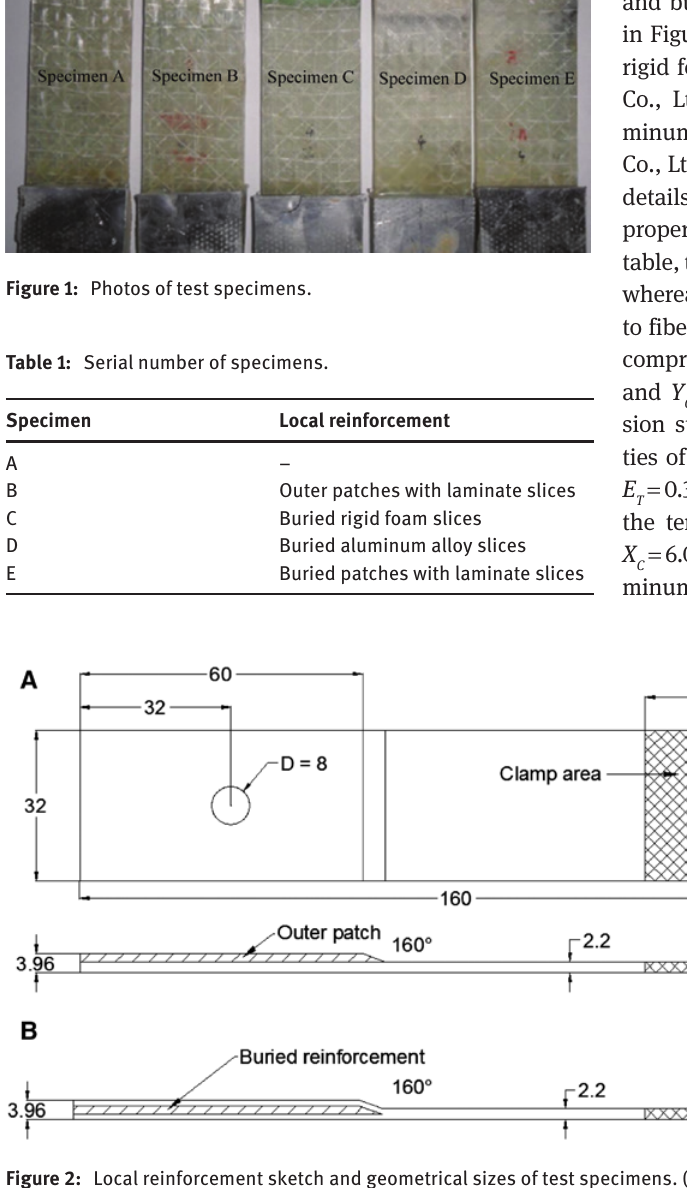
Figure 2: Local reinforcement sketch and geometrical sizes of test specimens. (A) Outer reinforcement plies (dimensions: mm). (B) Buried reinforcement slices (dimensions: